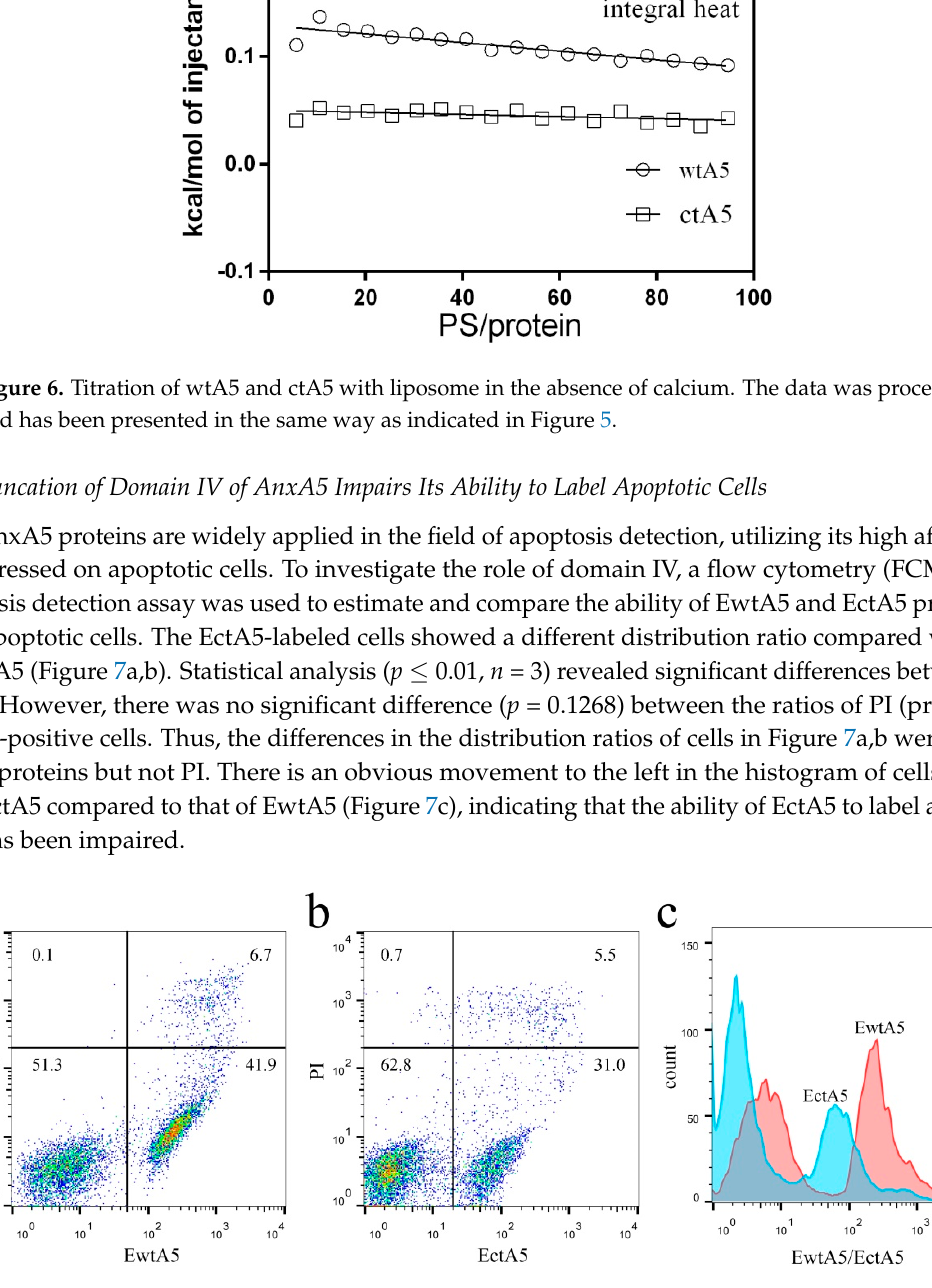
Figure 7. Apoptotic cells labeled with EwtA5 or EctA5 protein. ( a ) Dot plot of apoptosis-induced cells labeled with 25 nM EwtA5 and PI. The numbers shown in the quadrants represent the ratio of the cells. ( b ) Dot plot of apoptosis-induced cells labeled with 25 nM EctA5 and PI. The numbers shown in the quadrants represent the ratios of the cells, which are different from that of EwtA5 ( p ≤ 0.01, n = 3). ( c ) Comparison between histograms of cells labeled with EwtA5 and EctA5. Compared to the histogram of cells labeled with EwtA5, there is an obvious movement to the left in that for